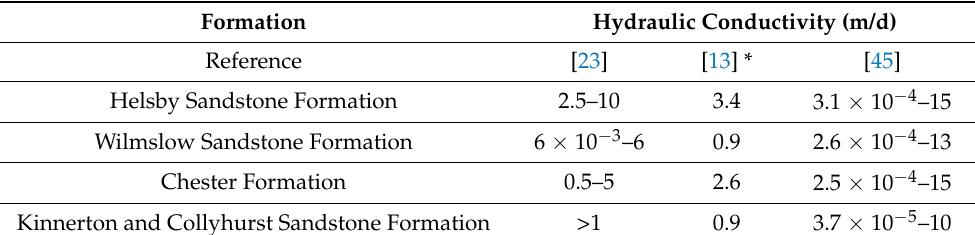
Table 1. Table of hydraulic conductivities taken from a range of literature sources. Developed from Allen et al. [45], Downing and Gray [13], Plant et al. [23].